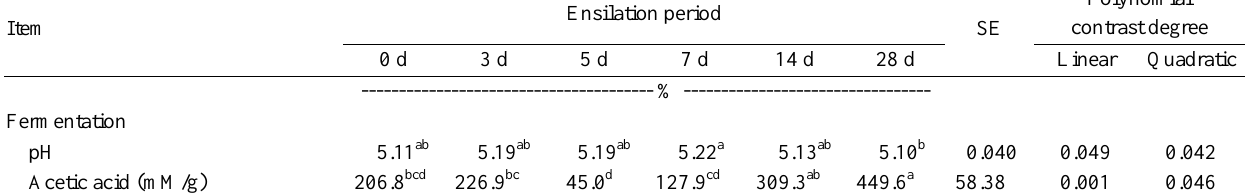
Table 3. The effects of the ensilation period of by-product feed-based silage on fermentation parameters and microbes 1